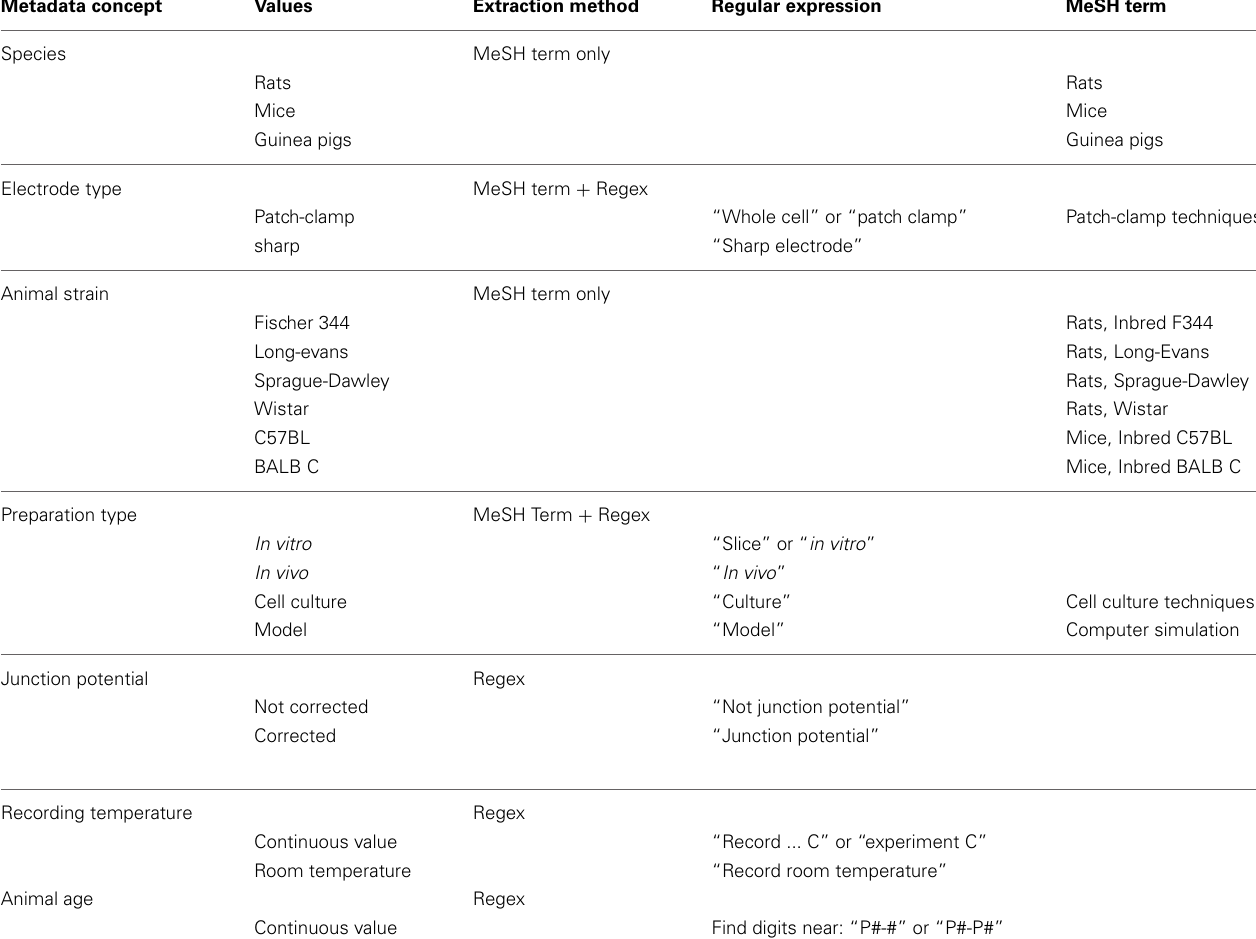
Table 2 | A partial listing of metadata attributes and extraction